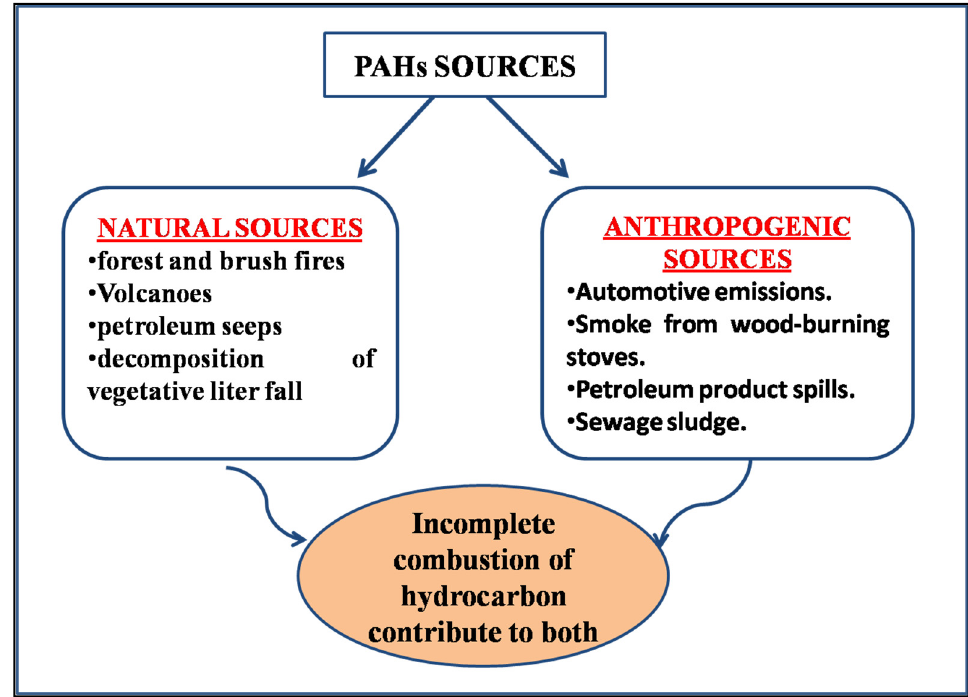
Figure 1. Sources of PAHs.